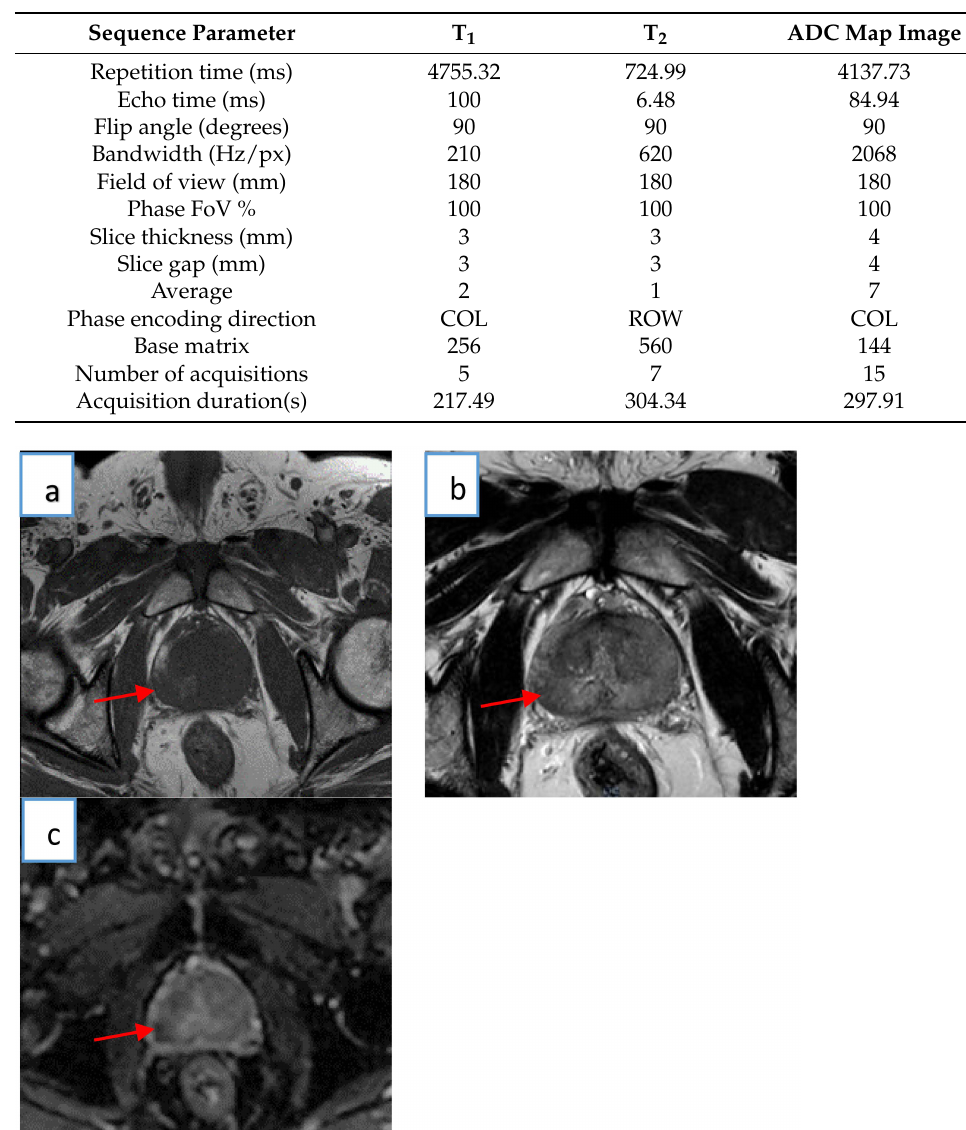
Table 2. Multiparametric MRI sequence parameters used in this study, including T 1 , T 2 , and ADC map images.